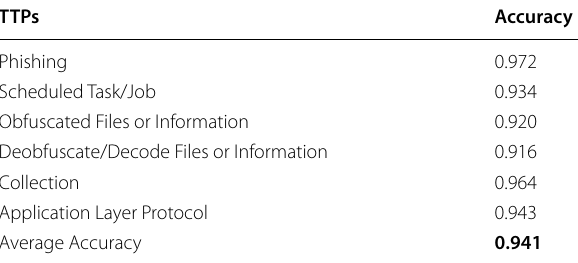
Table 11 Overall TTPs classification accuracy by using our TCENet on six different TTPs